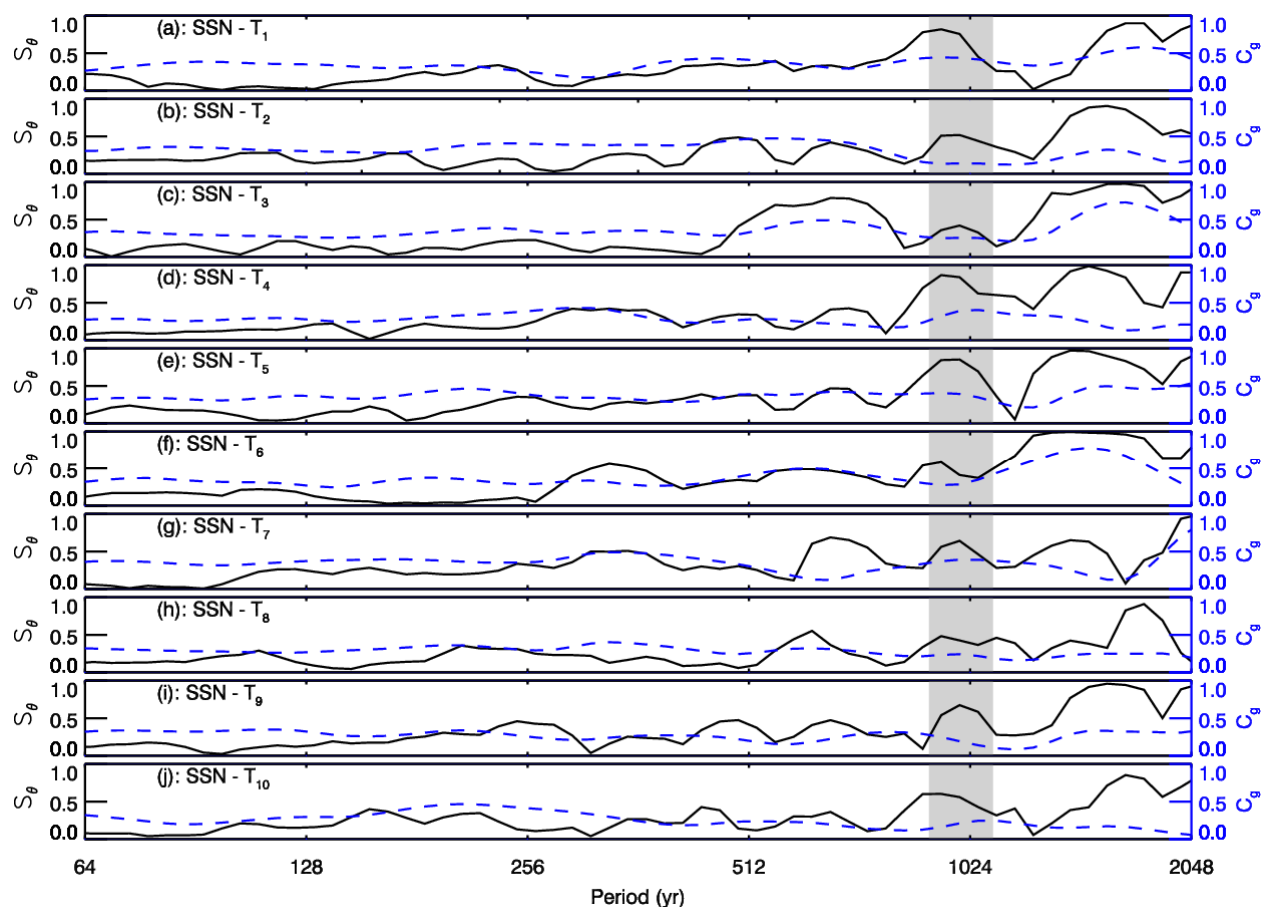
Figure 4. The phase angle strength ( S θ , solid line) and global wavelet coherence ( C g , blue dashed line) between SSN and temperatures plotted against period. The shaded region marks the millennial period (roughly 900 years to 1100 years).